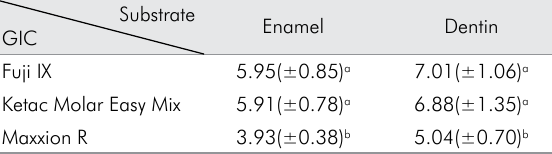
Table 2. Mean (standard deviation) of μSBS (MPa) for all experimental groups to primary enamel and dentin.